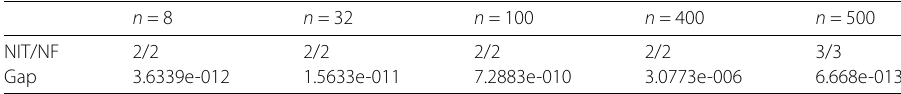
Table 1 Numerical results of Example 1